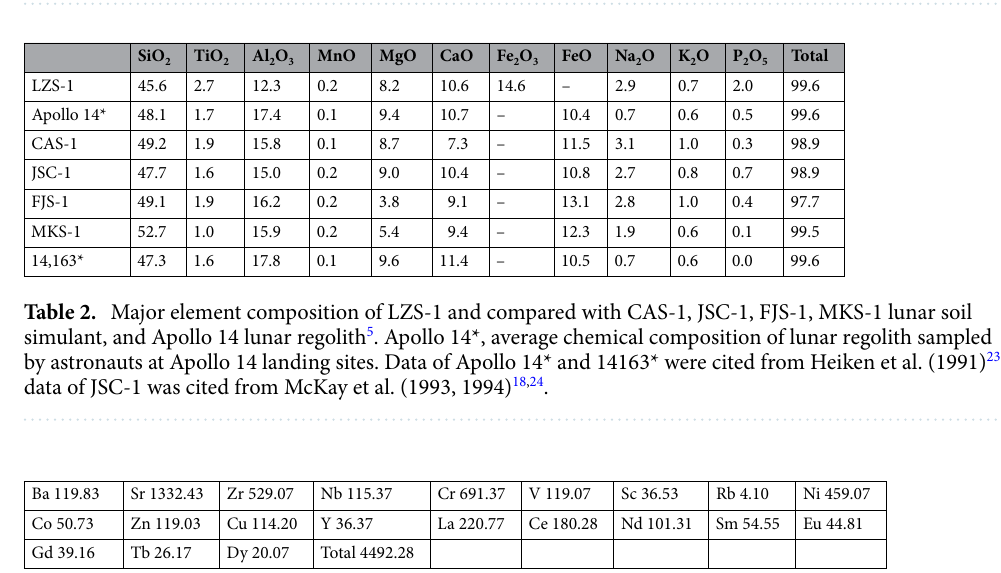
Table 3. Trace element abundances of LZS-1 lunar soil simulant.